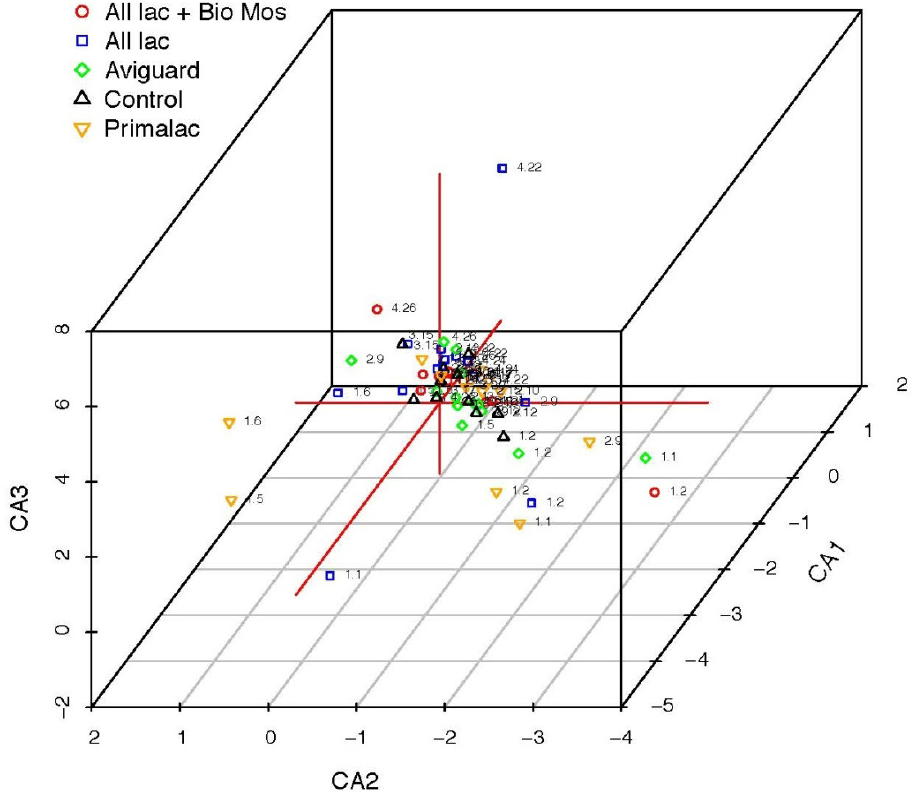
Figure 4. Correspondence analysis of microbial community patterns generated by 16S rRNA analysis of litter samples collected from four sequential flocks of broiler chickens administered probiotics or prebiotics and reared in research housing. Each point represents a single sample; the five treatments are represented by color and symbol type as shown in the legend. Labels for each point indicate litter cycle (1–4), followed by week of sample collection